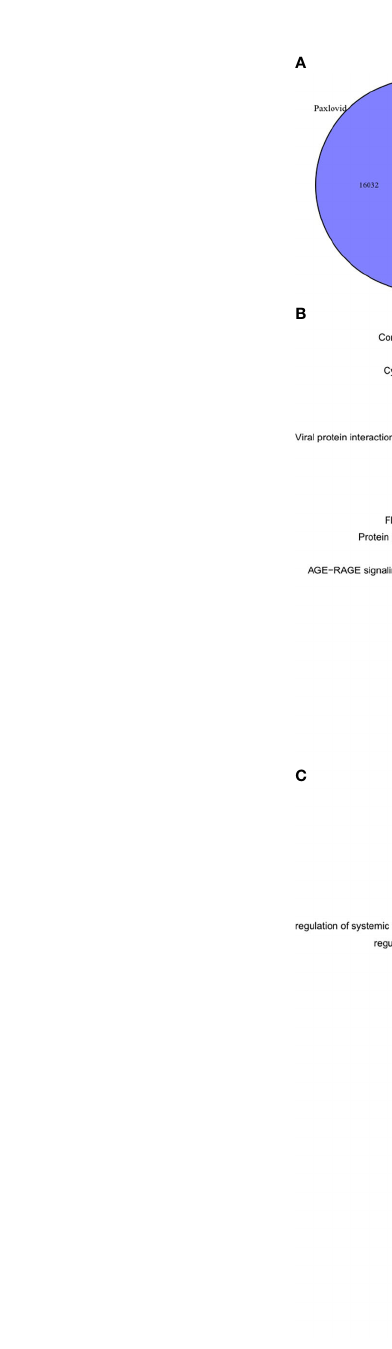
FIGURE 5 Functional characterization of Paxlovid against LUAD/COVID-19 intersecting genes. (A) Venn diagram depicting intersecting genes of Paxlovid and LUAD/COVID-19. (B) Kyoto Encyclopedia of Genes and Genomes (KEGG) pathway of intersecting genes of Paxlovid and CRC/COVID-19. (C) Gene ontology analysis of intersecting genes of niacin and